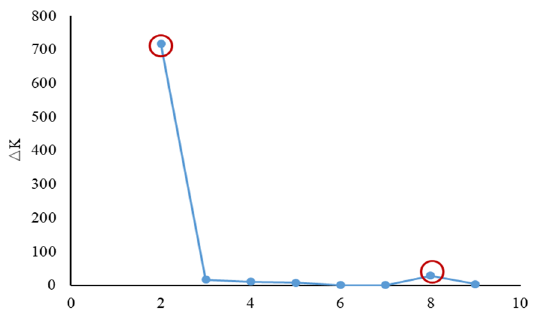
Figure 2. Neighbor ‐ joining cluster analysis of 640 rice accessions based on SSR markers.